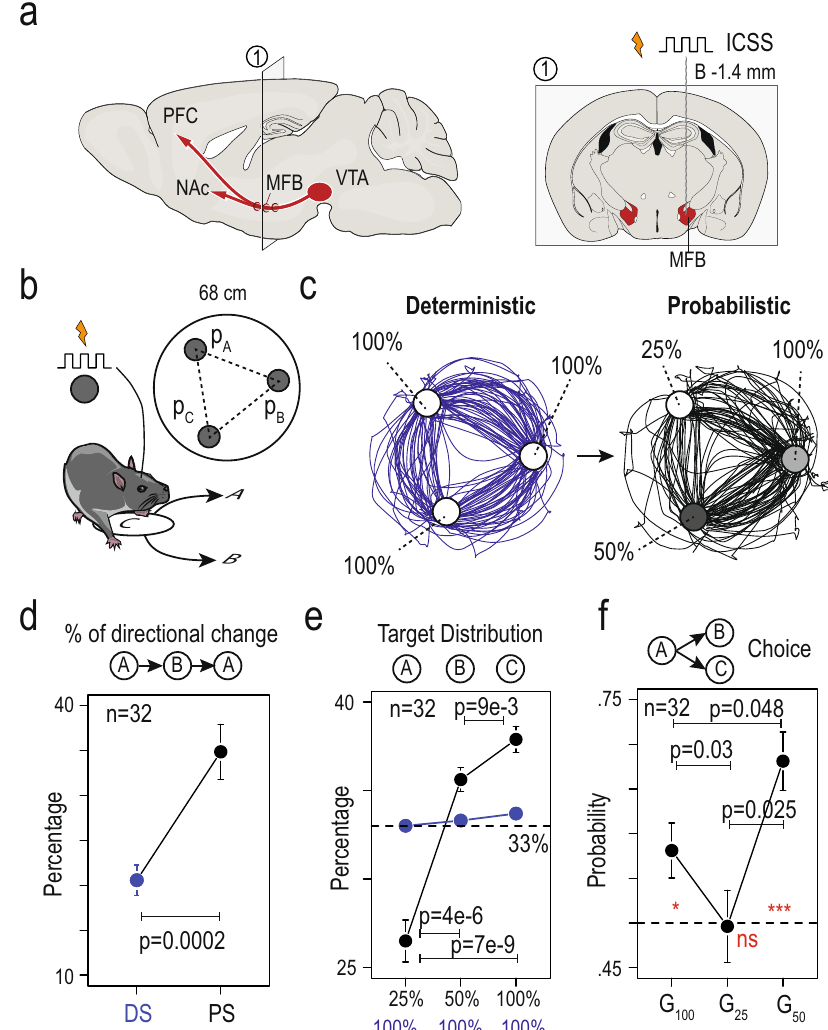
Fig. 1 Mice exhibited suboptimal behavior and exploratory choices in a spatial version of a multi-armed bandit task with probabilistic settings. a Mice were implanted unilaterally with bipolar stimulation electrodes to deliver electrical stimulation at the level of the medial forebrain bundle in order to support intracranial self-stimulation (ICSS) behavior. Right: a coronal section of the mouse brain illustrating a representative electrode positioned in the MFB at bregma − 1.4 mm AP. b Schematic of the behavioral paradigm: mice are placed in a circular open- fi eld (interior diameter = 68 cm), with three equidistant targets (A, B, and C, labeled on the open- fi eld fl oor, 35 cm distance between targets) that are associated with a given probability ( P A, P B, or P C ) of ICSS reward delivery when the animal is detected in a 60 mm zone around the target. c Sample trajectories for one mouse under the deterministic setting (DS) of the task, in which each of the three targets were rewarded by an ICSS with P = 100% (left panel, blue), and in the probabilistic setting (PS), in which the three targets were associated with distinct probabilities of ICSS delivery ( P A = 100, P B = 50, and P C = 25%) (right panel, black). Two stimulations could not be delivered consecutively in the same zone, therefore animals learned to alternate between targets with a circular pattern in the DS (blue), and a less stereotyped pattern in the PS (black). d Comparison of the percentage of directional changes during DS (blue) and PS (black) (two-sided paired Wilcoxon rank test, p = 0.0002, n = 32). e Repartition of visits to the three targets. Under the DS (blue), animals distributed uniformly their choices of visiting each of the three options (around 33%, Friedman rank sum test, p = 0.82). During the PS (black), animals reorganized their behavior and visited more frequently options with greater probabilities of reward (Friedman rank sum test, p = 7e-8, and two-sided paired Wilcoxon Test with holm correction p = 4.e-6, 7e-9 and 9e-3 for the three comparisons, n = 32). f Probability to choose the option with the highest probability of reward for the three possible gambles: G 100 = choice of 50% over 25%, G 25 = choice of 100% over 50%, and G 50 = choice of 100% over 25%. Red asterisk: Comparison with a true mean of 0.5 (two-sided one sample t -test with Holm correction, n = 32) for G 100 ( p = 0.026), G 25 ( p = 0.92), and G 50 ( p = 1.4e-5). Paired comparison (paired t -test with Holm correction, n = 32) for G 100 – G 25 ( p = 0.03), G 100 – G 50 ( p = 0.048), and G 25 – G 50 ( p = 0.025). For ( d – f ), data are shown as mean ± sem. Boxplot shown median, quartiles, and extreme values. See also source